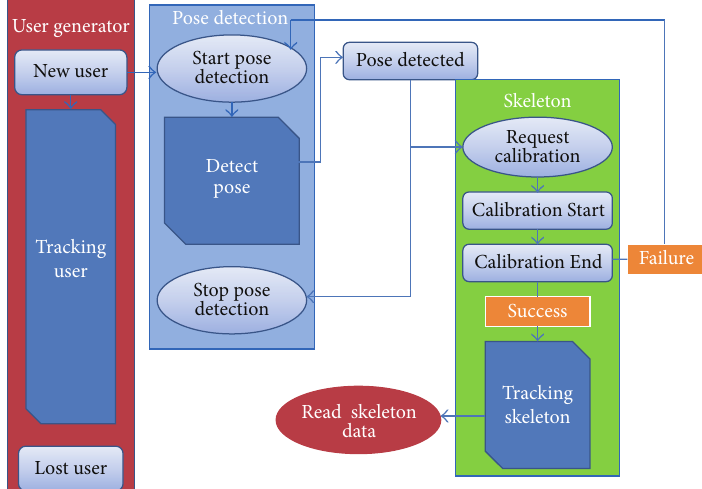
Figure 5: Skeleton detection flowcharts of the Kinect.